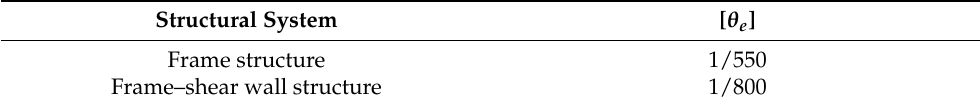
Table 8. Elastic story drift limit for the frameworks.